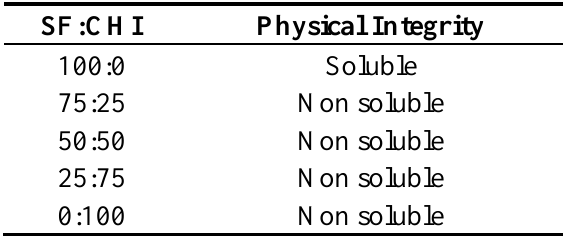
Table 1. Results of physical integrity test of the SF/CHI